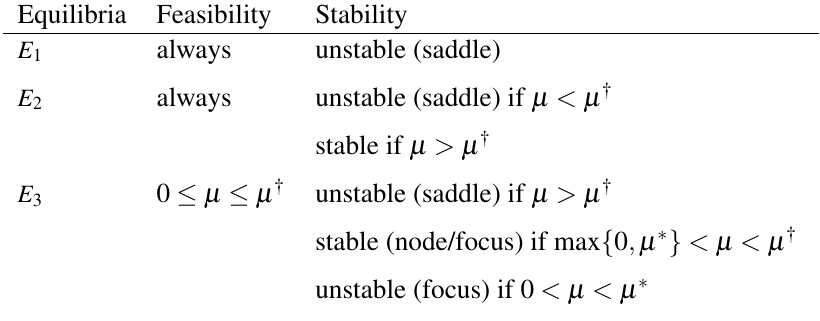
Table 1 Behaviour and conditions of feasibility and stability of equilibria for the model (4), with 0 < h < 1, µ > 0, and µ ∗ and µ † respectively defined in (11), (10). Note that if µ > µ † , E 3 is unfeasible, having negative coordinates, although without direct biological meaning, this equilibrium collides with E 2 when it becomes feasible, going through a transcritical